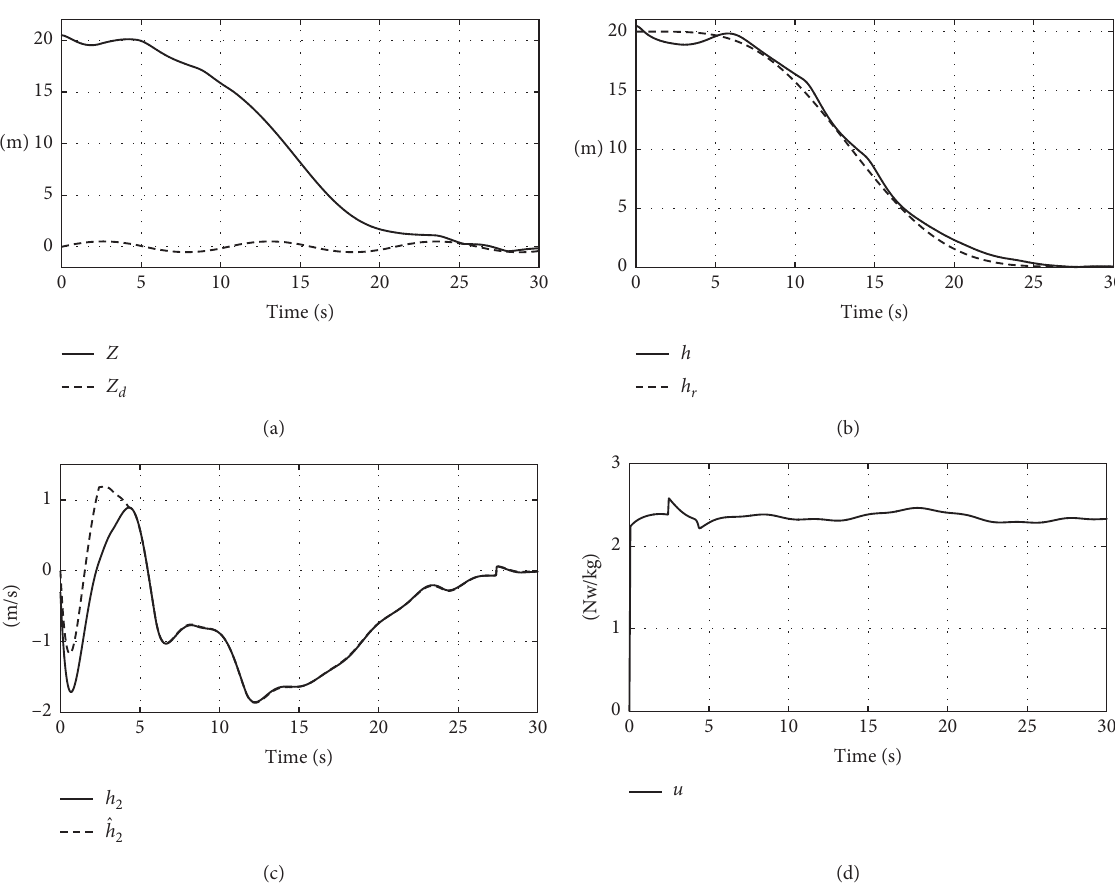
Figure 2: The closed-loop response of the VTOL-UAV perturbed by a crosswind when tracking a trajectory to land over a moving platform, with a programmed time of 30 seconds: (a) VTOL-UAV landing task; (b) comparison between actual and desired positions; (c) comparison between actual and desired velocities; (d) control